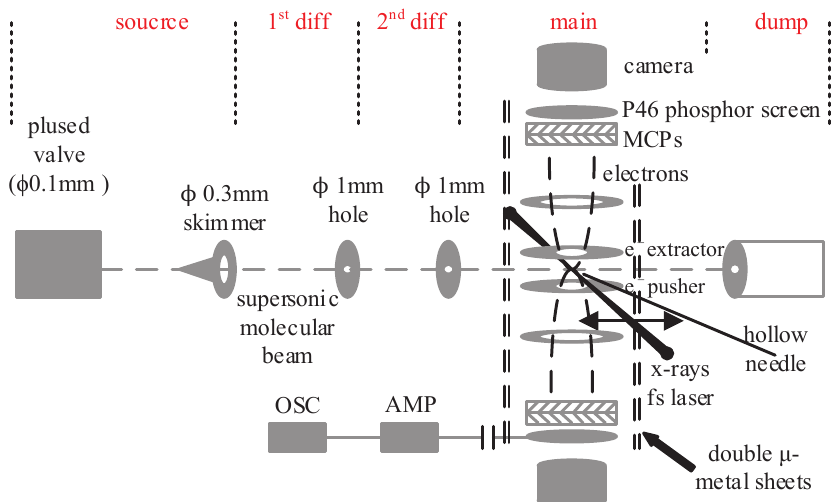
Figure 1. Schematic view of the CpVMI spectrometer. The gas sample can be prepared as either a supersonic molecular beam or an effusive molecular beam. Charged particles produced in the interaction region are projected onto the detector (stacked MCPs with a P46 phosphor screen), and the images are recorded by a camera. The ion TOF signals are recorded using an oscilloscope.